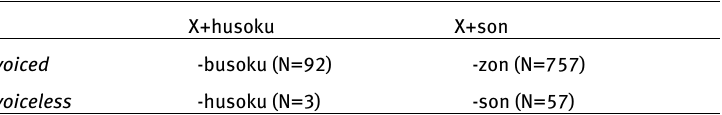
Table 3. Distribution of voiced/voiceless variants of /X+husoku/ and /X+son/ in the CSJ